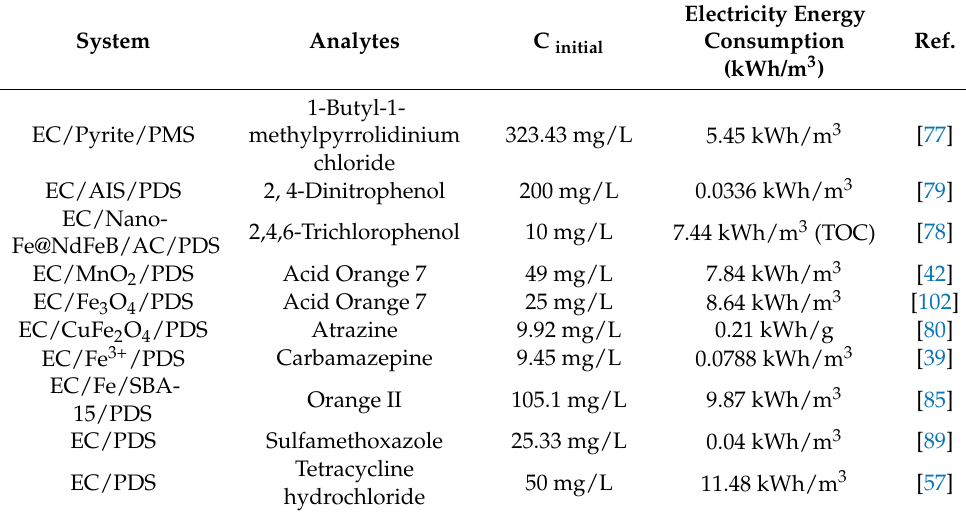
Table 6. The energy consumption of EPOPs in previous